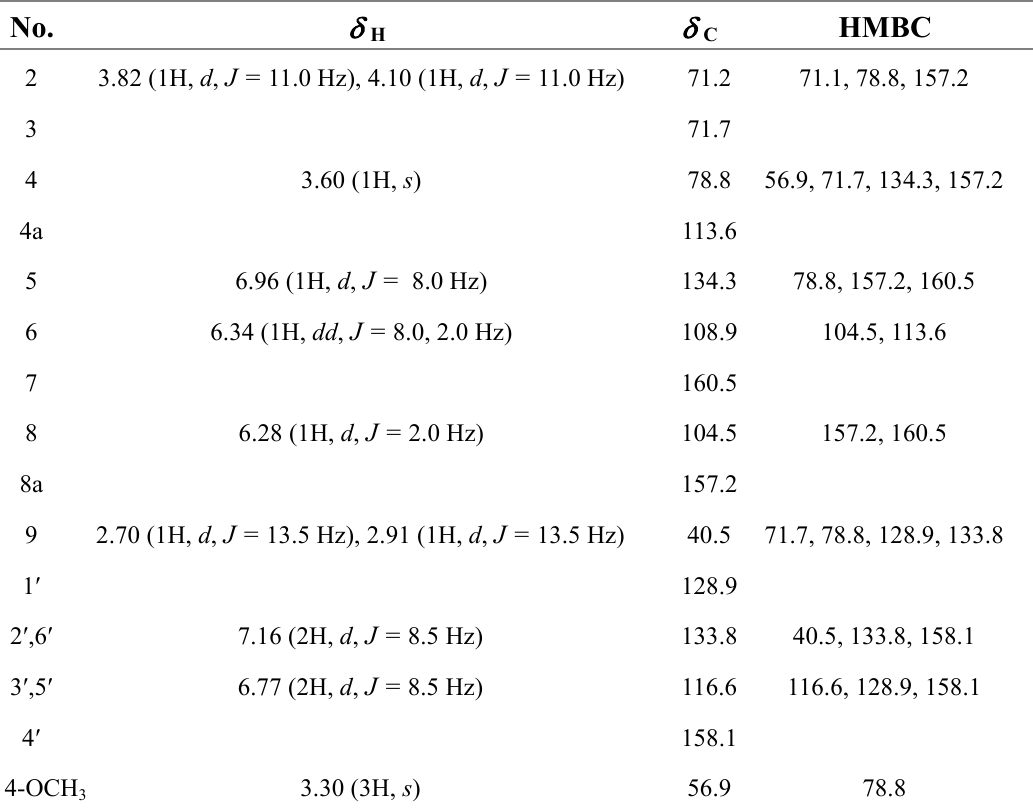
Table 1. NMR spectral data for ( 4 ) in acetone- d